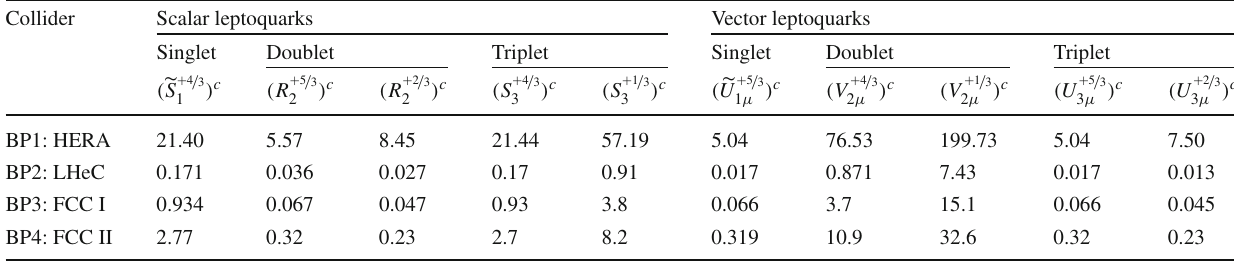
/ 3 / 3 and U − 1 can not be produced at e - p collider due to the gauge lier, S − 2 3 3 μ structure of the Lagrangian